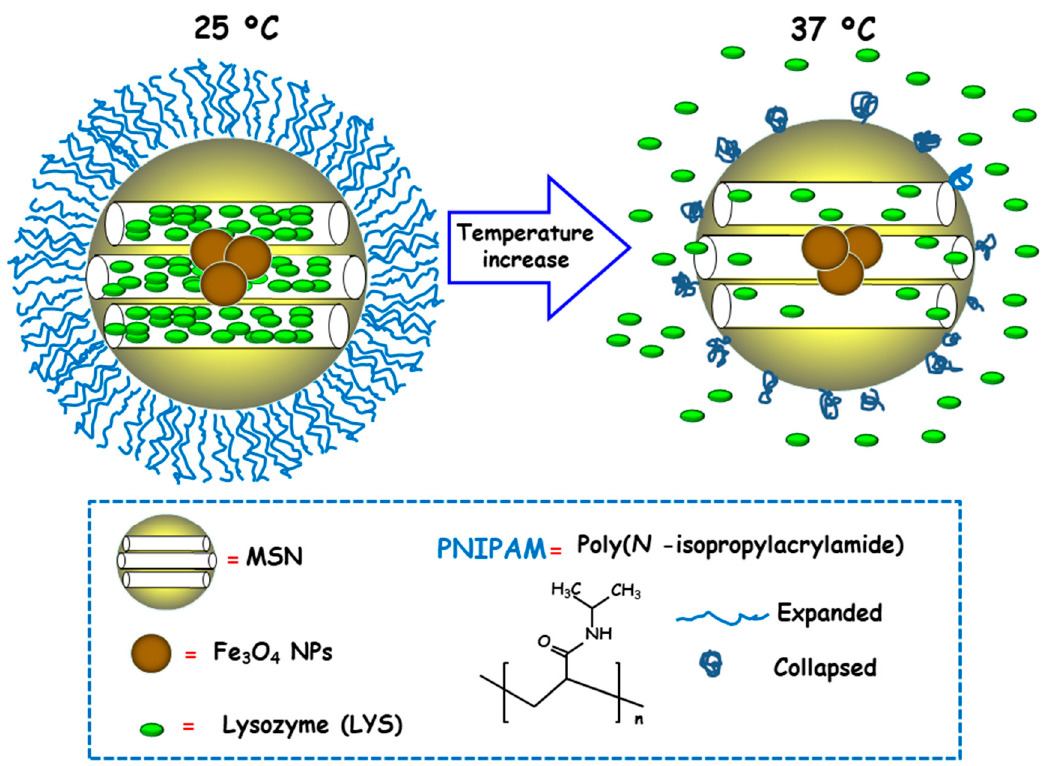
Figure 9. Schematic representation of the operating mechanism of temperature-responsive antimicrobial nanosystems consisting of core-shell nanoparticles (NPs) comprised of Fe 3 O 4 cores and mesoporous silica shells, loaded with lysozyme (LYS) and coated with a thermosensitive poly(N-isopropylacrylamide) (PNIPAM) layer. Adapted from ref. [96]. At 25 ºC PNIPAM is in hydrated extended brush form, closing the mesopores and hindering cargo release. The temperature increase to 37 ºC makes the polymer to adopt a hydrophobic collapsed form, producing pore uncapping and LYS release.